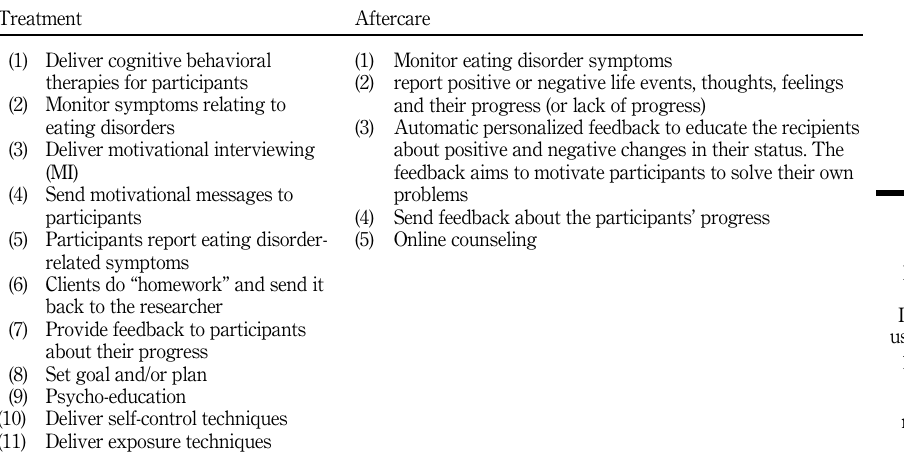
Table 2. Examples of